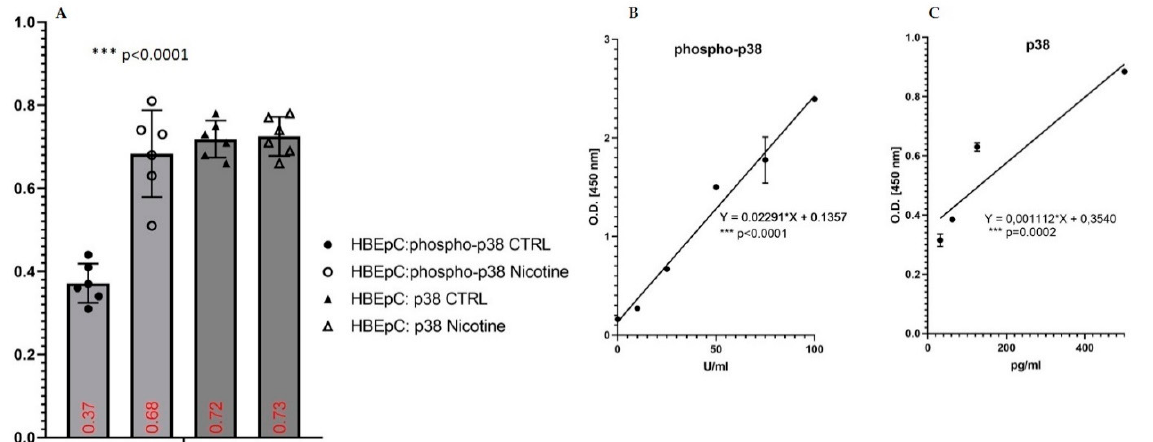
Figure 8. Induction of phospho-p38 and p38 by nicotine in HBEpC. ( A ): ELISA experiments; ( B ): regression equation linearity for phosphor-p38; ( C ): regression equation linearity for phosphor-p38performed with Prism. Statistical significance is analyzed with one-way ANOVA with multiple-comparison and post hoc test with Bonferroni correction. Experiments are performed at least two times in triplicate.